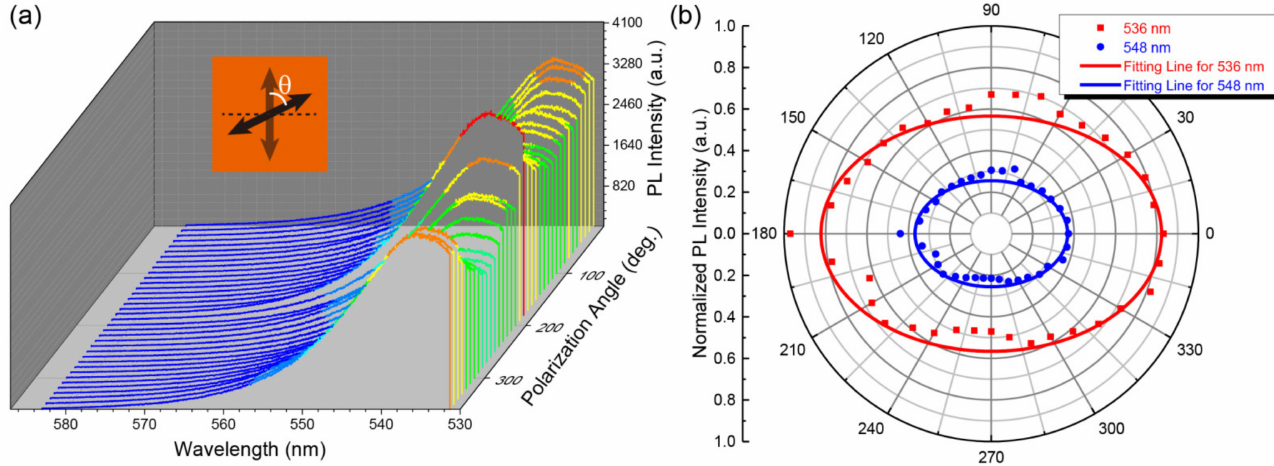
Figure 3. ( a ) Waterfall plot of PL spectra with different incidence polarization angles at room temperature. ( b ) Polarization angle dependence of the normalized PL intensity for luminescence wavelength of 536 and 548 nm,